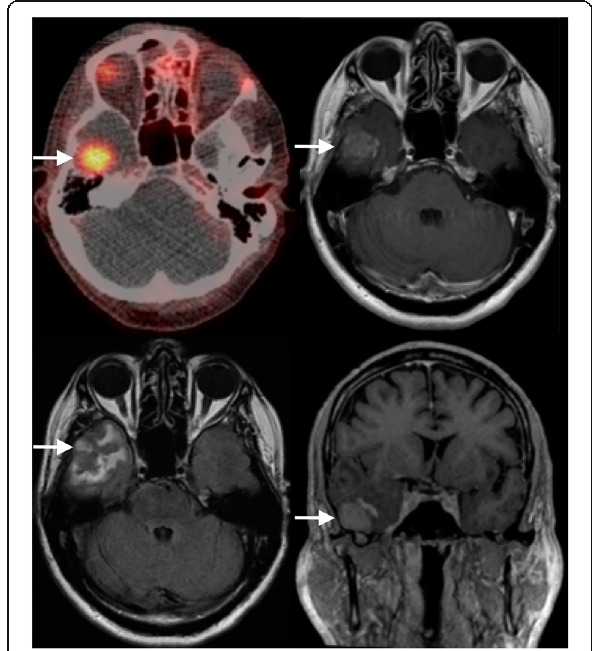
Fig. 2 Selected images through the skull base from the [^68 Ga]Ga- THP-PSMA PET/CT and subsequent MRI. Top left: axial fused PET/CT image revealing focal uptake in the right middle cranial fossa; bottom left: axial FLAIR MRI showing white matter oedema in the right temporal lobe; top (axial) and bottom (coronal) right: post- contrast enhanced T1-weighted MR images demonstrating an enhancing lesion in the floor of the right middle cranial fossa in close contact with the dura